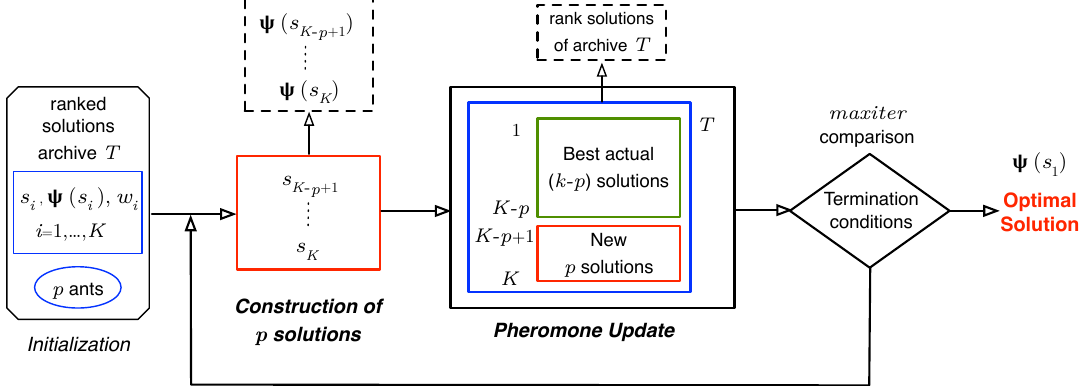
Figure 5. ACO R main loop